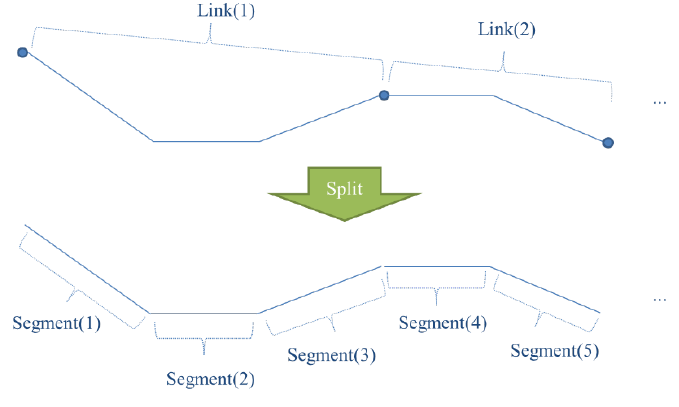
Figure 2. Splitting polyline objects of PND links into the unit of